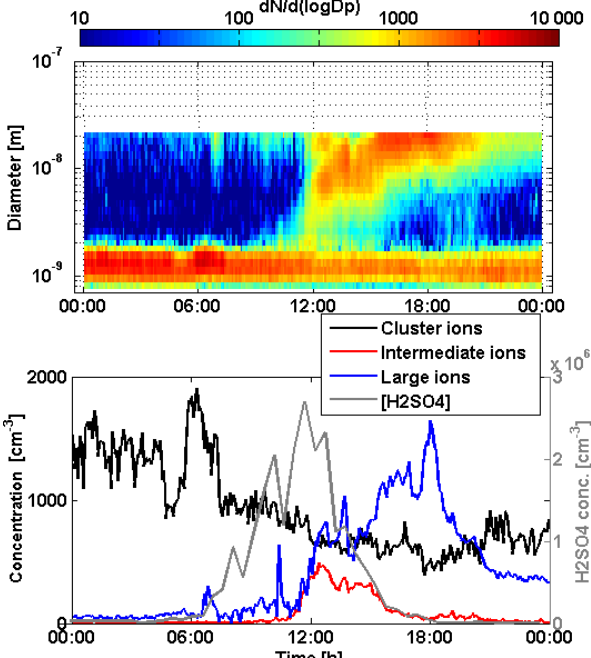
Figure 17. An exemplary negative ion number size distribution dur- ing a new particle formation measured with the NAIS (upper panel), and concentration of negative cluster ions (0.8–2.0nm), intermedi- ate ions (2.0–7.0nm), large ions (7.0–20nm) and gas phase sulfuric acid (lower panel) on 5 May 2007 in